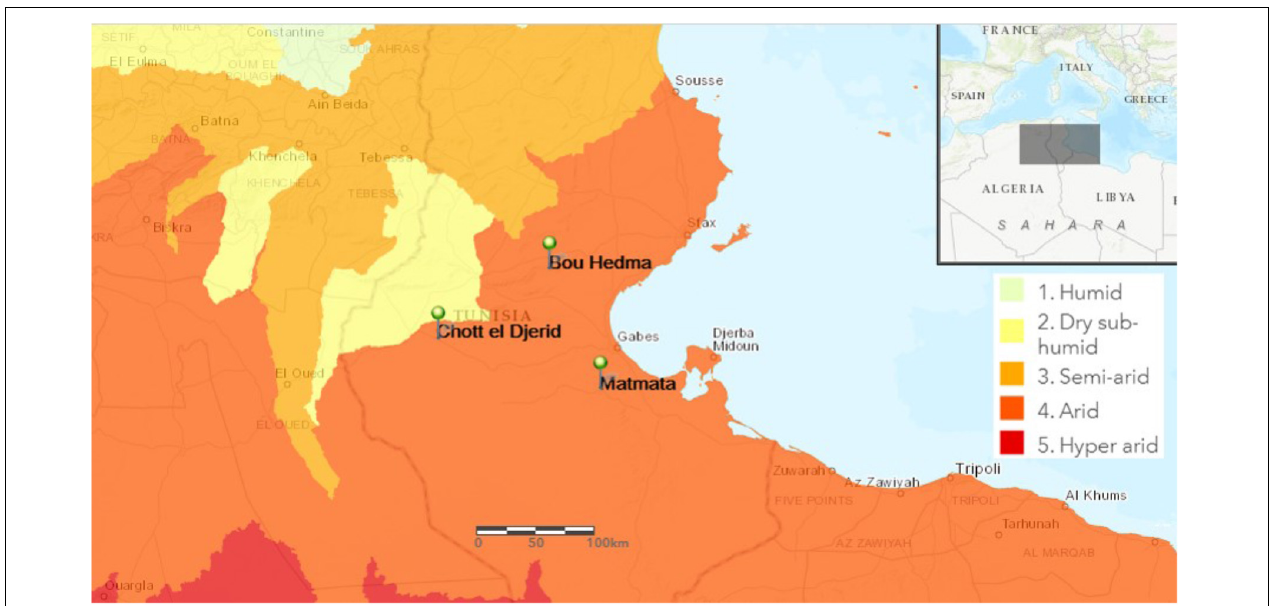
FIGURE 1 | Map of Tunisia showing the location of the sampling sites. Bou-Hedma national park (Sidibouzid), Chott-Djerid (Tozeur), and Matmata